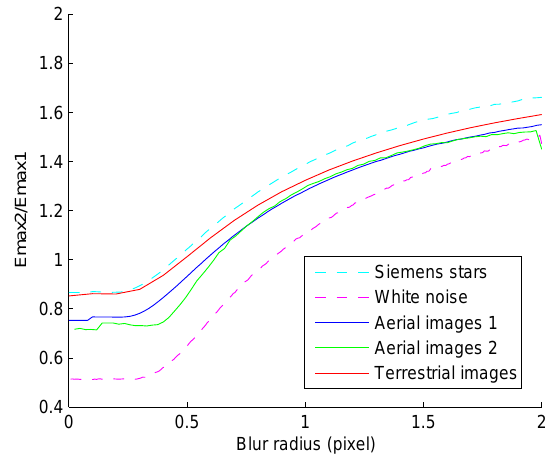
Figure 5: Ratios of ¯ E max values for synthetic (dashed lines) and real (solid lines) images.